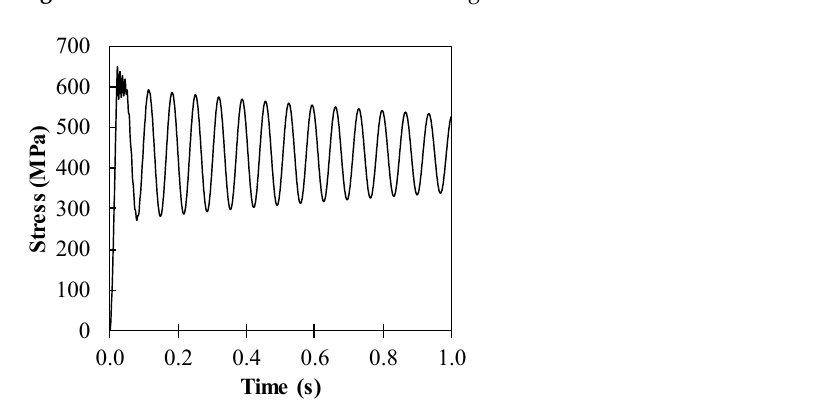
Figure 9. Stress evolution in CFRP of the hybrid system containing 8.4 mm thick steel slab and 5.0 mm thick φ 100 mm CFRP frame.